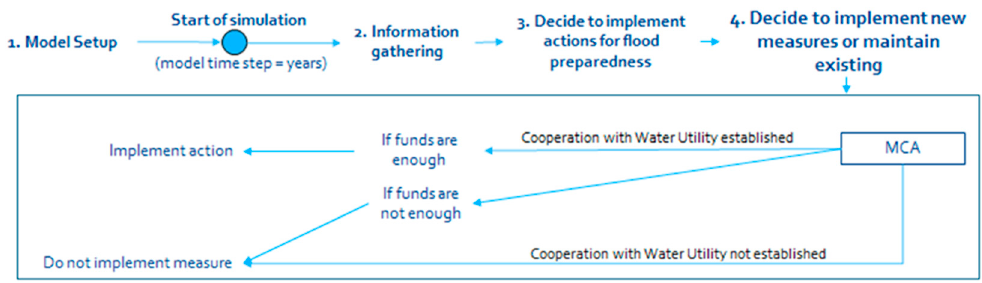
Figure 6. Procedure for implementing new measures or maintain existing.